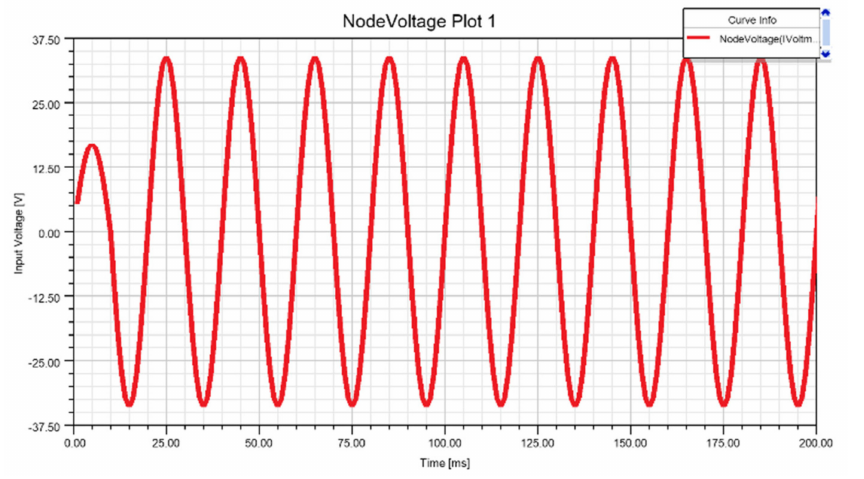
Figure 8. Input Voltage to a Transformer.